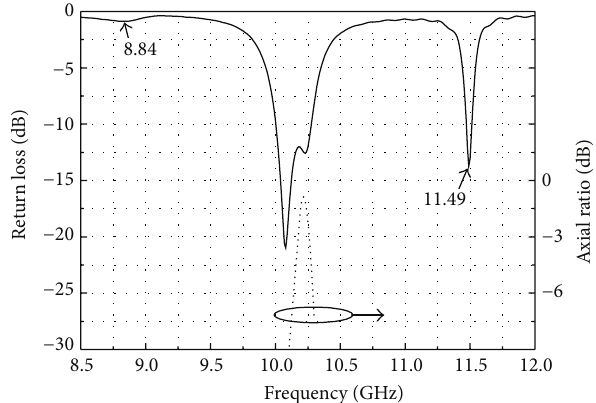
Figure 2: Simulated return loss and axial ratio of the proposed